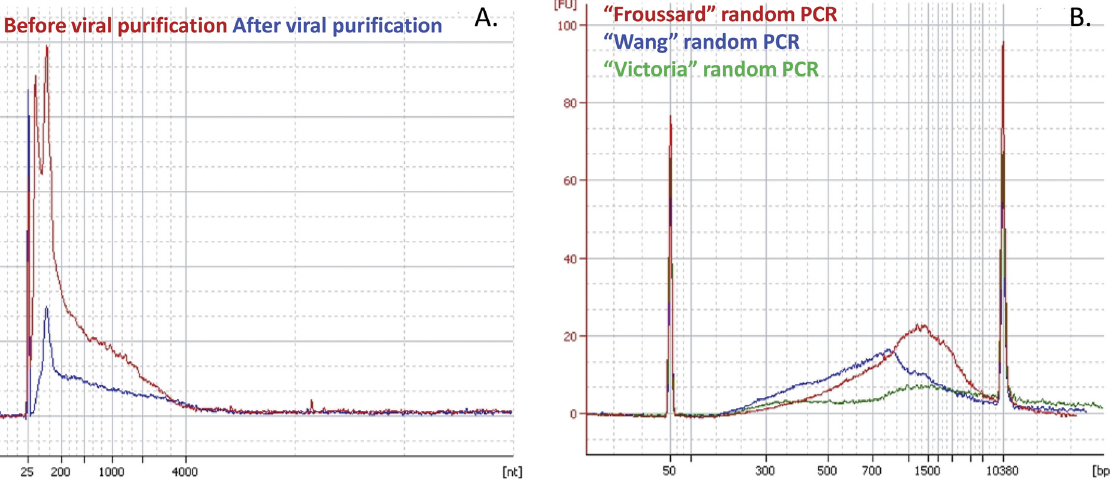
Fig 2. Nucleic acid profiles analyzed on a 2100 Expert Agilent Analyzer. A. RNA profile of an EMEM sample spiked with the reference viruses before (red) and after (blue) viral purification, run on a Pico RNA chip. B. DNA profile of a dsDNA sample (originated from RNA) amplified either with Froussard (red), Wang (blue) or Victoria (green) random PCR, run on a DNA7500